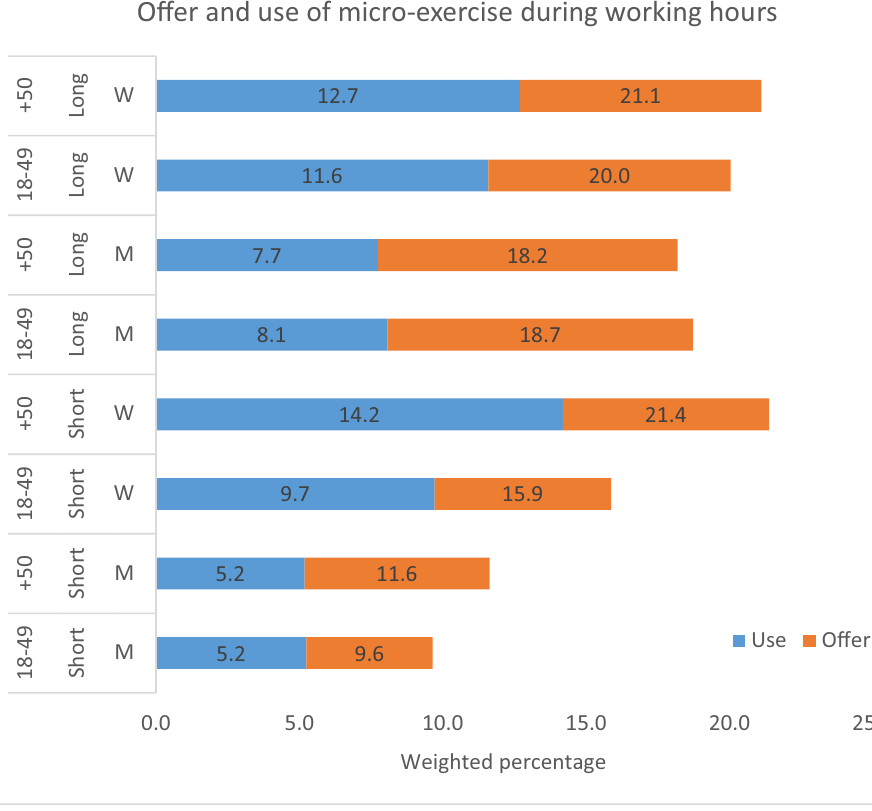
Using micro-exercise N Weighted percentage